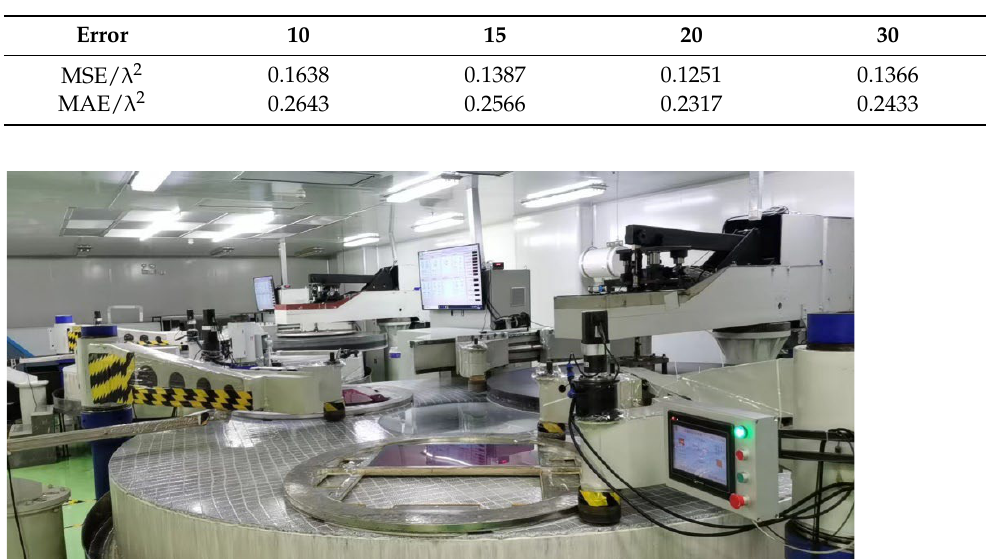
Table 6. Mean square error and mean absolute error of astmag on different time steps.